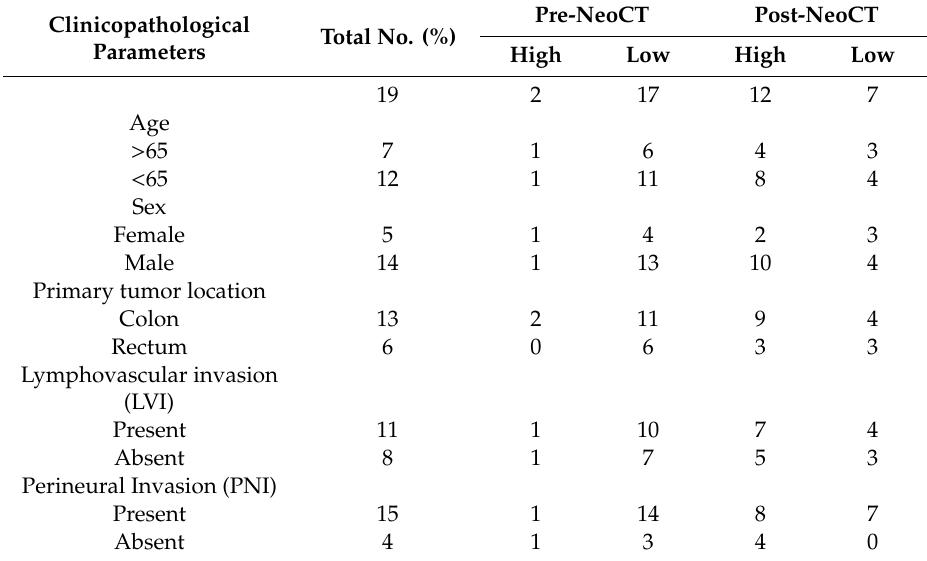
Table 1. Characteristics of patients with colorectal cancer ( n =